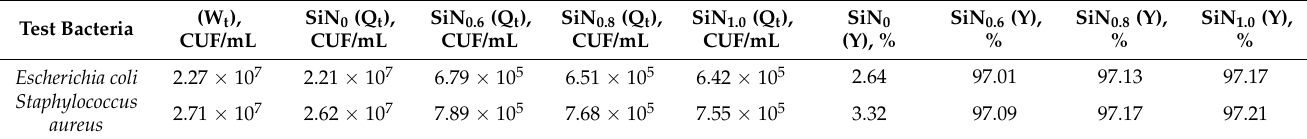
Table 4. Evaluation of antibacterial activity of as-prepared